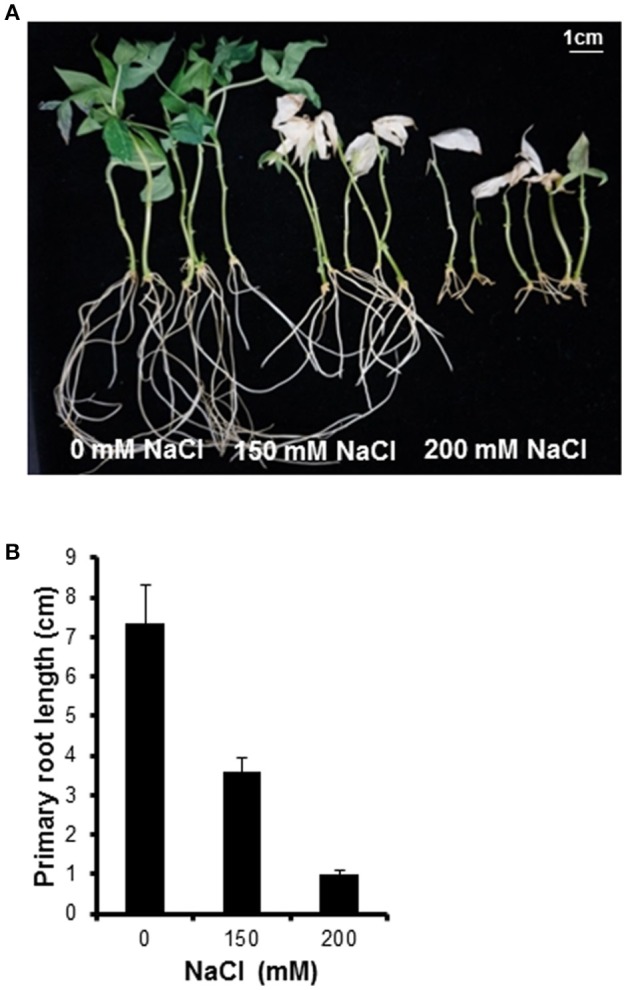
Plant phenotype after treating with various NaCl concentrations. (A) Morphological observation of cassava after 14-day salt stress treatment. NaCl concentrations of 0, 150, and 200 mM were used. (B) Inhibition of primary root elongation by salinity stress. Error bars represent the means ± SD (n = 5–6).